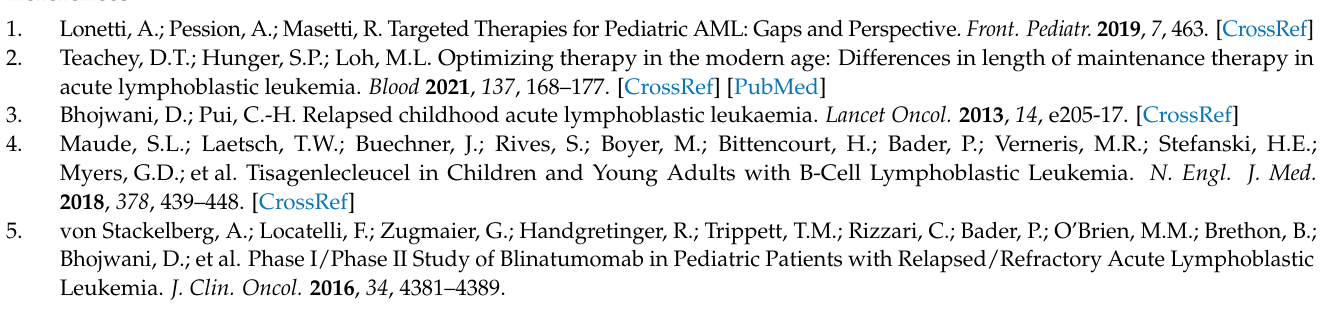
Table S2: Allogeneic stem cell transplantation performed in our series; File S1: Primary data of